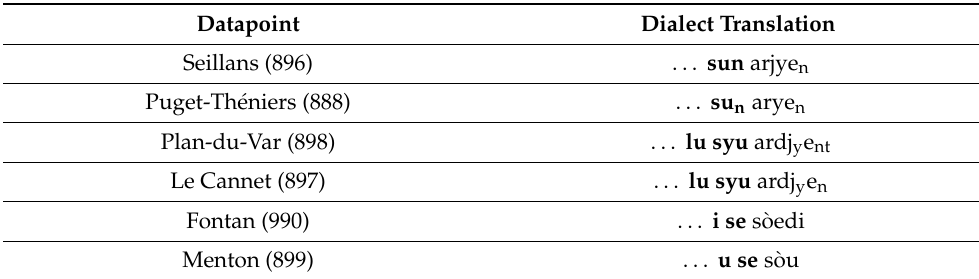
Table 10. Summary of relevant data from ALF 57: (we will give him) his money ; Fr. (lui rendions) son argent ; with a simplified